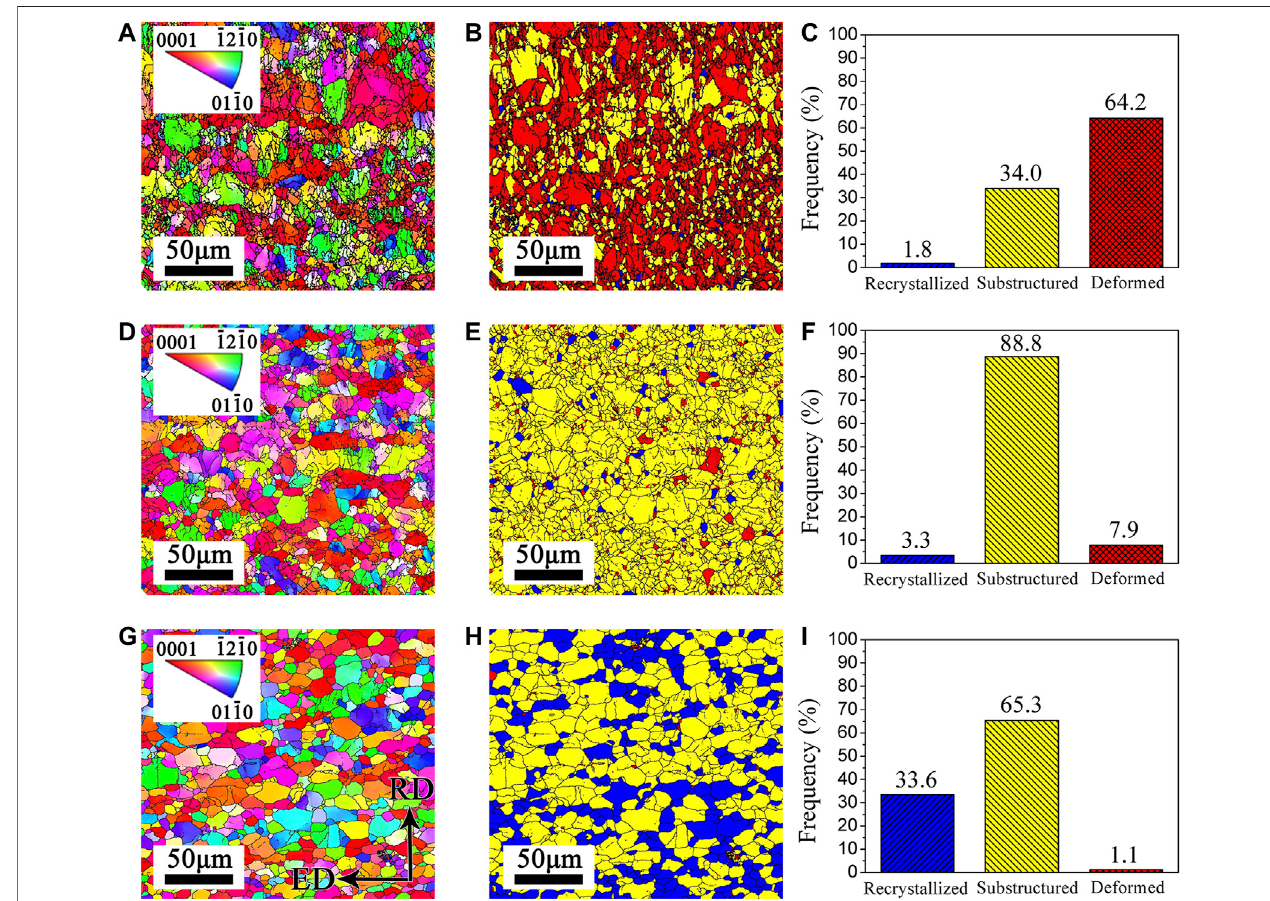
FIGURE 8 | Microstructures of the LAY410 alloy at the same rate with different temperatures: (A,B,C) T (cid:2) 150 ° C, (D,E,F) T (cid:2) 200 ° C, (G,H,I) T (cid:2) 250 ° C.